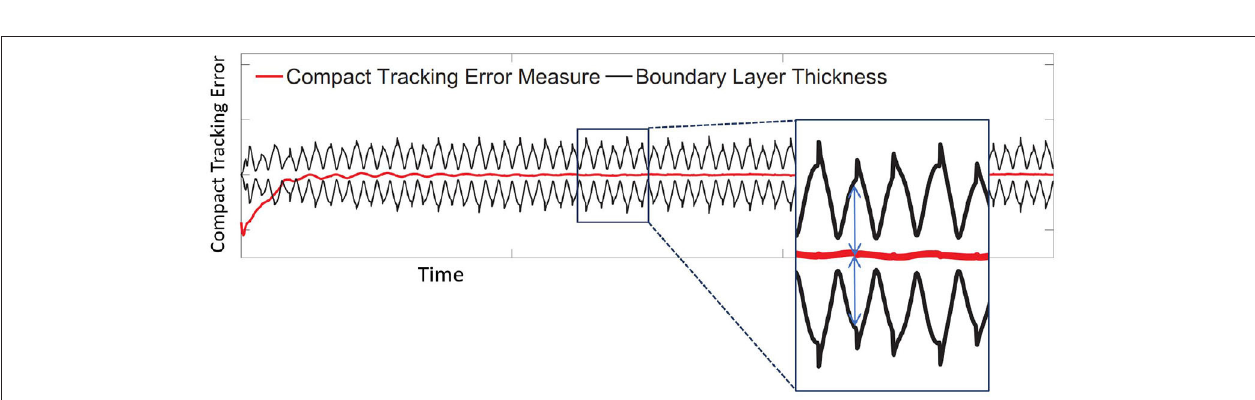
FIGURE 7 | Geometric representation of mapping from an n-dimensional hyperplane associated with varying parameters of the physical substructure model to the RSI. Prior to conducting an experiment, the range of possible values of the RSI is classified, on the basis of system instability as extremely sensitive (red), moderately sensitive (yellow), and slightly sensitive (green) ( Maghareh et al., 2017; Silva et al., 2020).